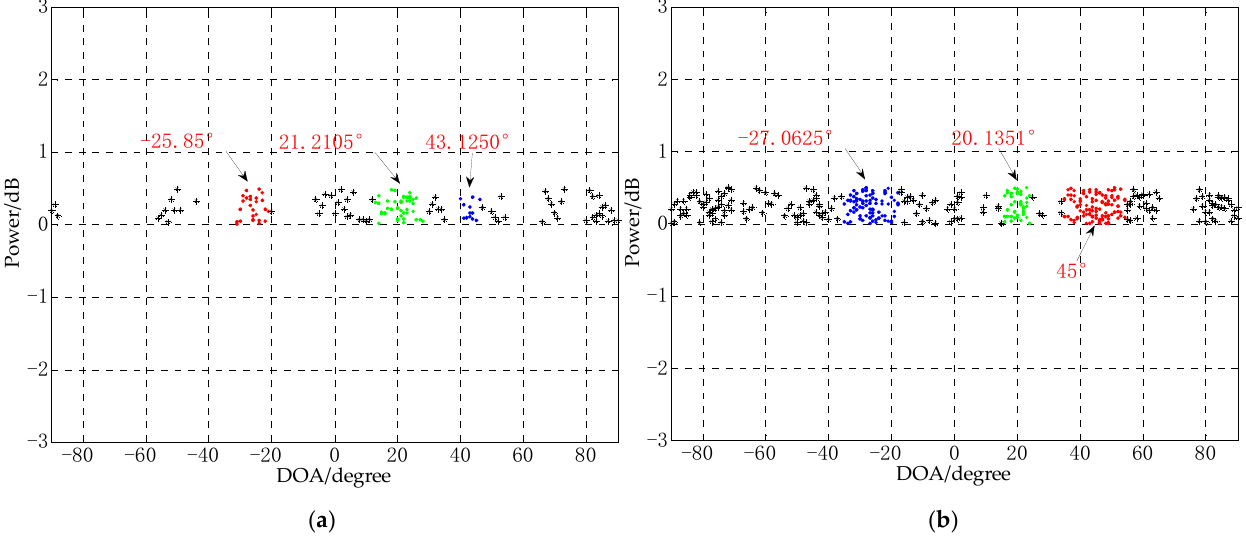
Figure 12. DOA estimation experiment under different number of snapshots, ( a ) snapshots = 10; ( b ) snapshots = 30.